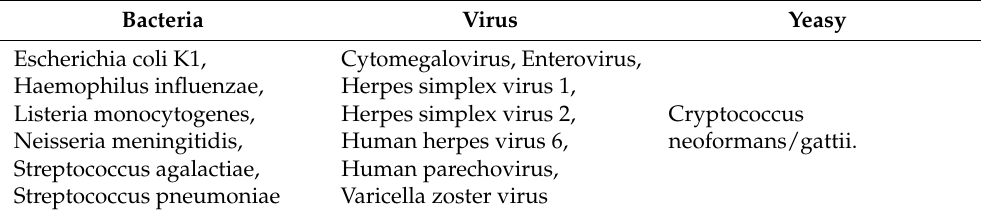
Table 2. Pathogens evaluated through PCR-Filmarray (BioMerieux,